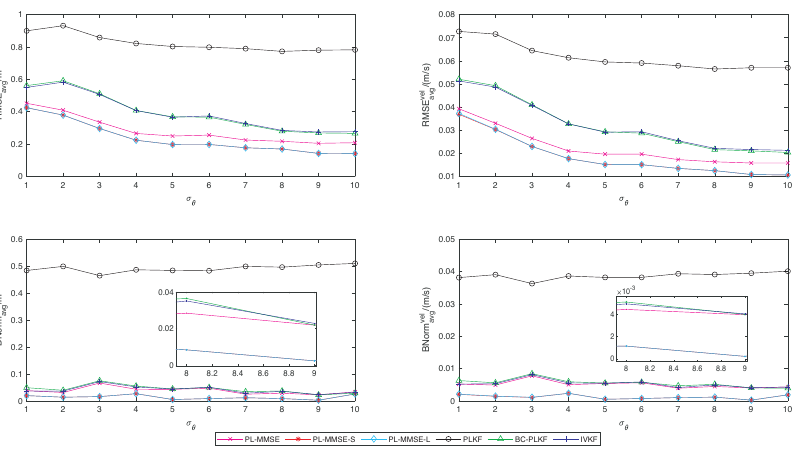
Figure 12. Time-averaged RMSEs, BNorms and bearing noise standard deviation at V = 0.2 m/s for the PL-MMSE, PLKF, BC-PLKF and IVKF algorithms, as well as, the PL-MMSE algorithm with nonlinear constraints proposed in the